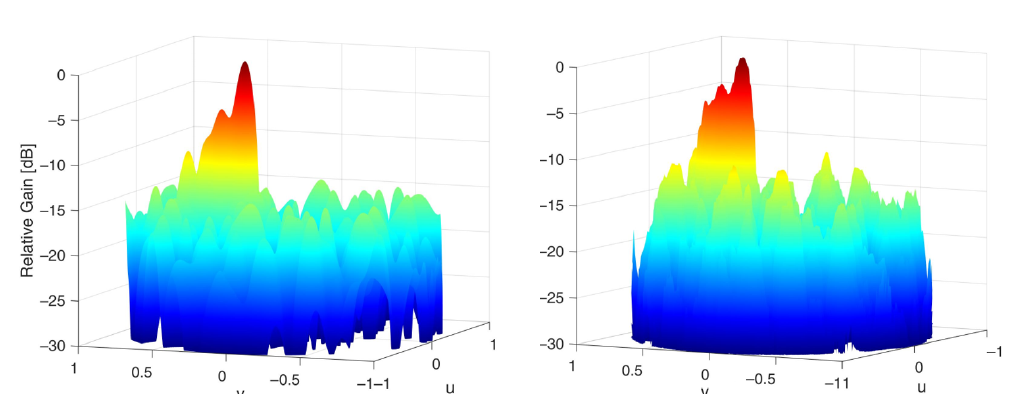
Figure 16. 3D radiation patterns at 30 GHz, obtained at the end of the optimization process ( left ) and through the prototype measurement ( right